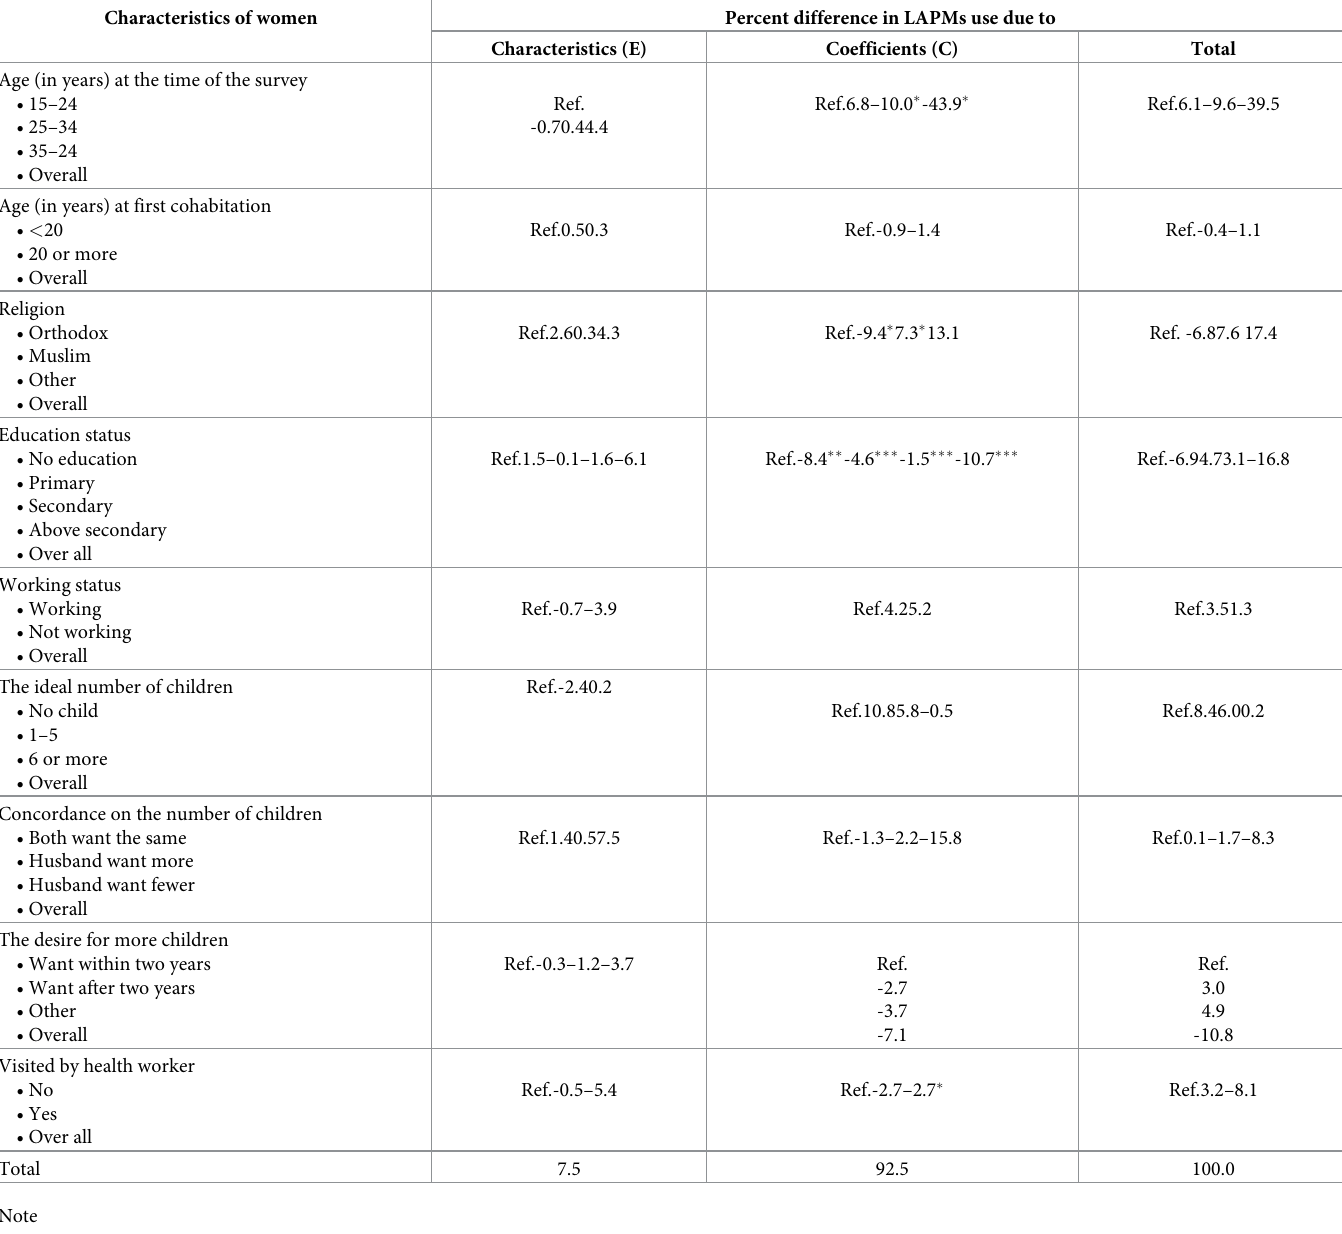
Table 3. Decomposition of the change in long-acting and permanent contraceptive methods use among married or in union reproductive-age women in Ethiopia by selected characteristics, 2005 to 2016. Characteristics of